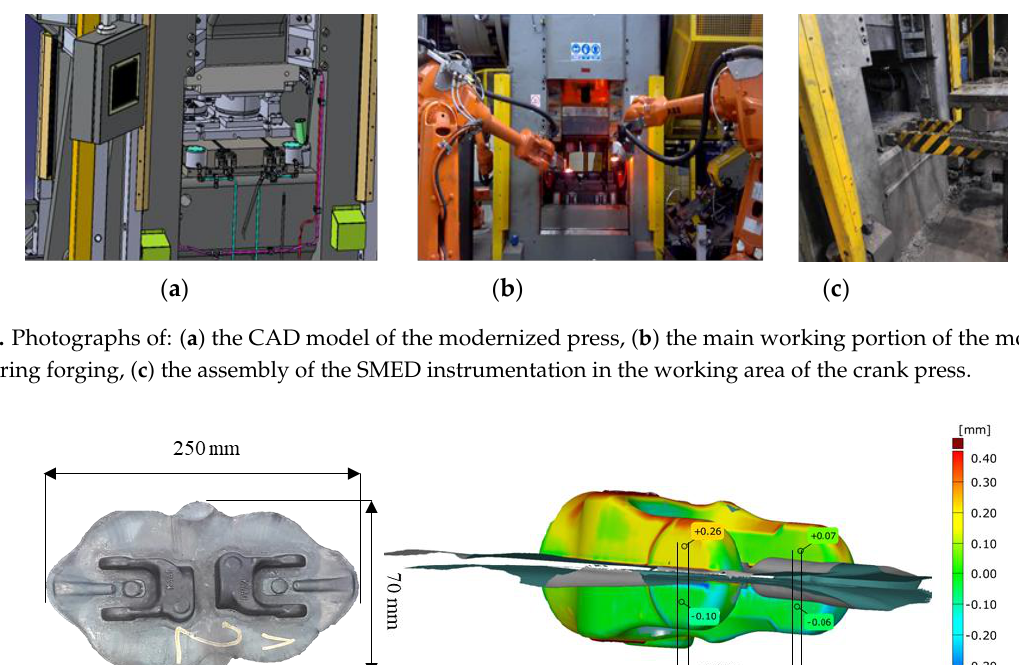
Figure 1. Photographs of: ( a ) the CAD model of the modernized press, ( b ) the main working por- tion of the modernized press during forging, ( c ) the assembly of the SMED instrumentation in the working area of the crank press. Table 1. Chemical compositions for tool steel and workpieces.